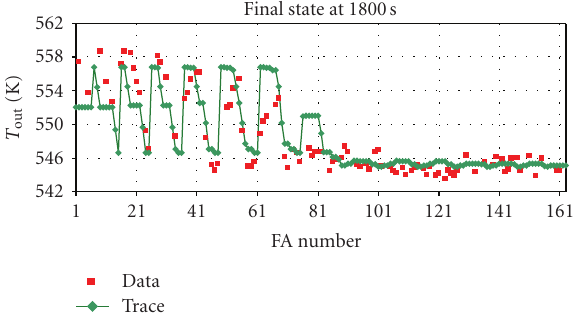
Figure 18: Comparison of the predicted coolant temperature at each FA outlet with data.